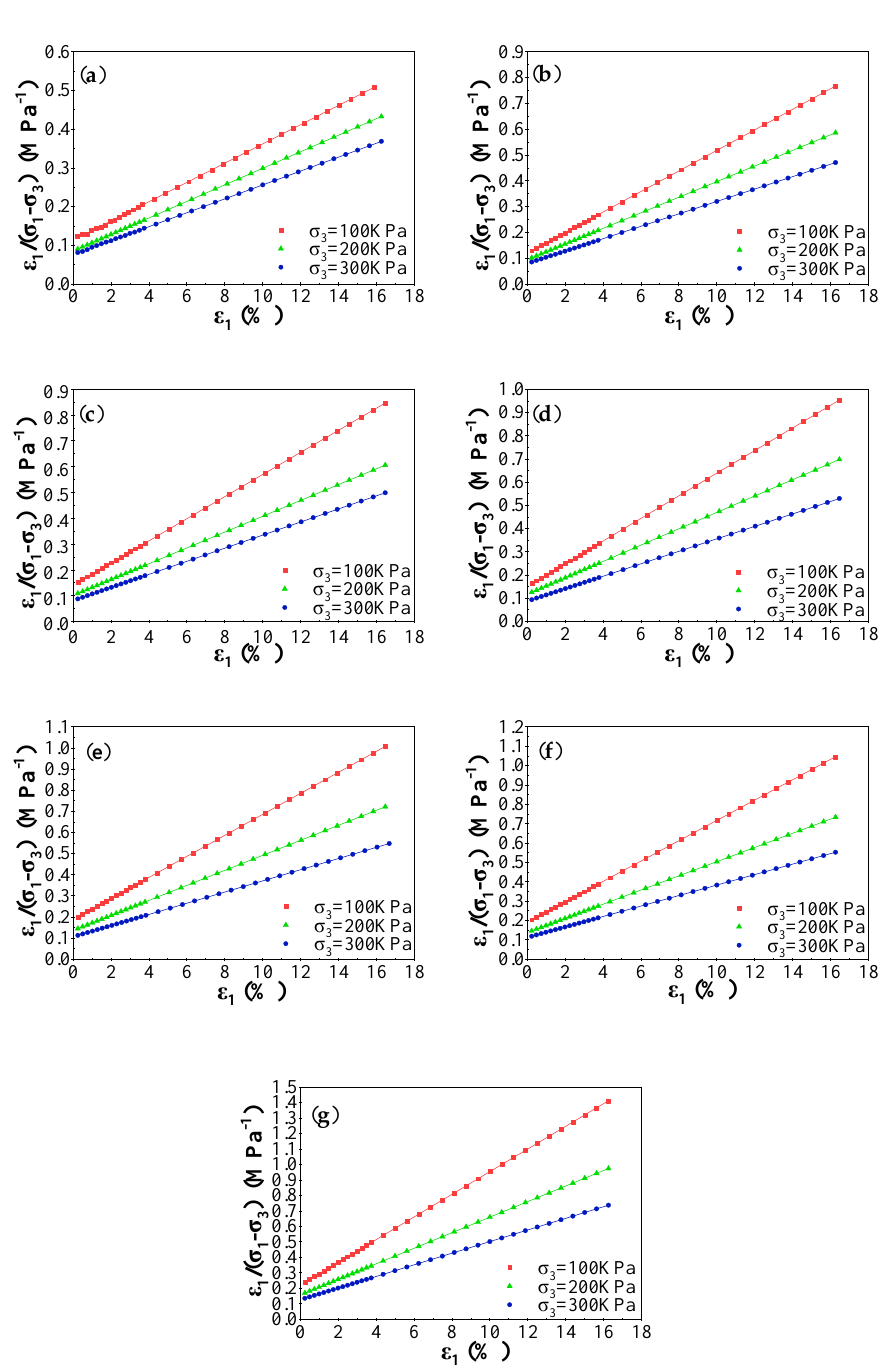
Figure 4. Drawing curves ε 1 /(σ 1 − σ 3 ) ‐ε 1 of samples to obtain parameters a and b: ( a ) FTC = 0, S = 0.5%; ( b ) FTC = 1, S = 0.5%; ( c ) FTC = 5, S = 0.5%; ( d ) FTC = 10, S = 0.5%; ( e ) FTC = 30, S = 0.5%; ( f ) FTC = 60, S = 0.5%; ( g ) FTC = 120, S = 0.5%. Table 6. Parameters a and b of curves ε 1 /(σ 1 − σ 3 ) ‐ε 1 under different conditions.